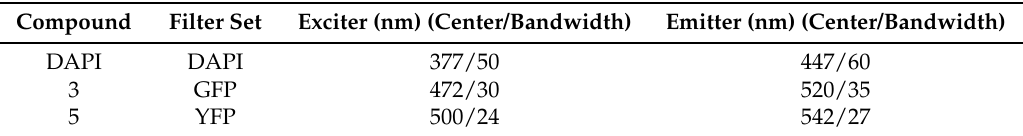
Table 3. Filter sets used for the cell